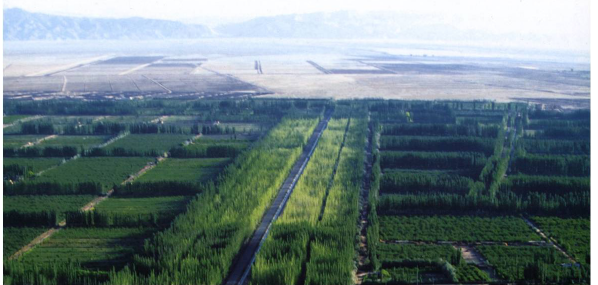
Figure 3. Aerial view of the northern edge of Kökyar I (adapted from Aksu Prefectural Greening Committee,